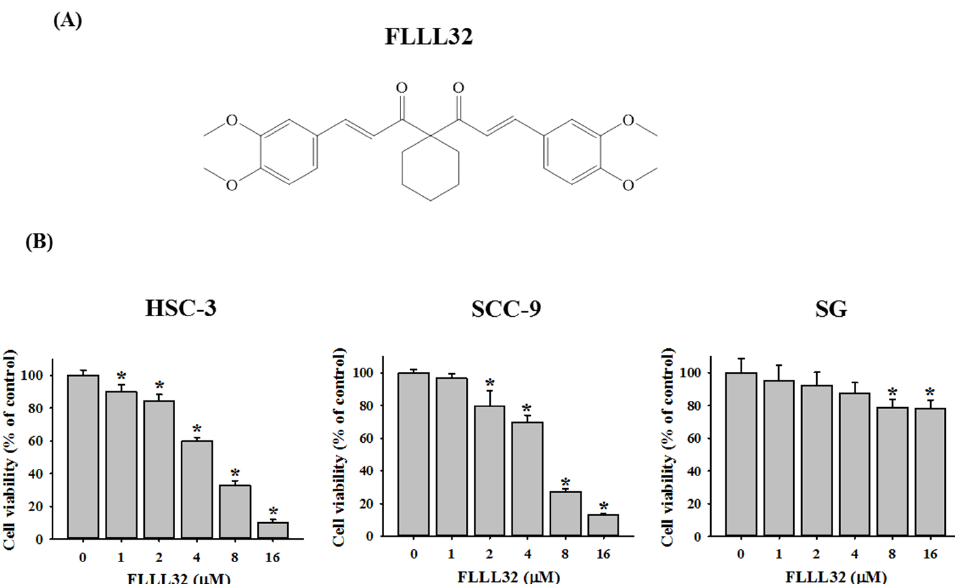
Figure 1. FLLL32 inhibits cell viability in oral cancer cells. ( A ) The chemical structure of FLLL32. ( B ) The cell viabilities of HSC-3, SCC-9, and SG were measured by an MTT assay after treatment with 0, 1, 2, 4, 8, or 16 µ M of FLLL32 for 24 h. Data are presented as the mean ± SD, and all experiments were independently repeated at least three times; * p < 0.05 compared with the vehicle